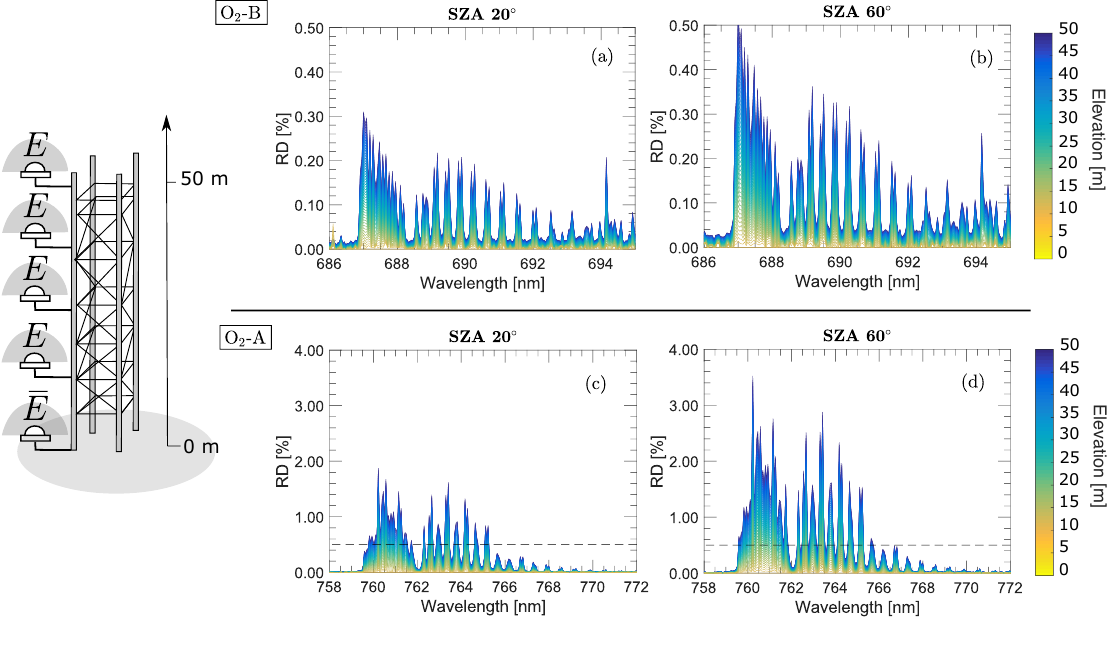
Figure 1. The percent (%) relative difference (RD) between the at–sensor ( E ) and at–surface ( E ) measured total solar irradiance for two different SZAs (20 ◦ and 60 ◦ ) for a range of target–sensor distances between 0 to 50 m. Panels ( a – d ); show the solar irradiance RD (%) corresponding to the O 2 –B and O 2 –A regions, respectively. The black dashed–line in the panels ( c , d ) indicate the maximum RD reached in the O 2 –B region to facilitate the comparison. Note the difference in the RD(%) scales in ( a , b ) versus ( c , d